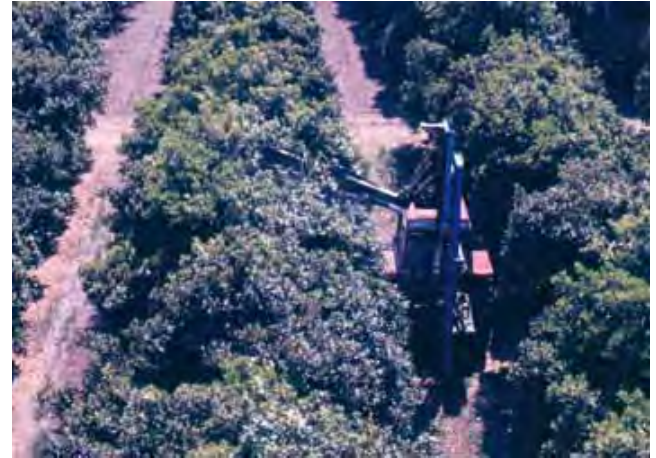
Fig. 9 - Mechanical topping.